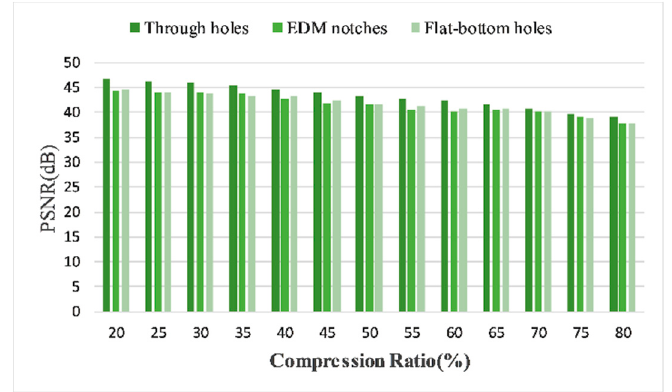
Figure 23. Comparative PSNRs between three kinds of defects in frequency domain, using 20 MHz SR experimental data.